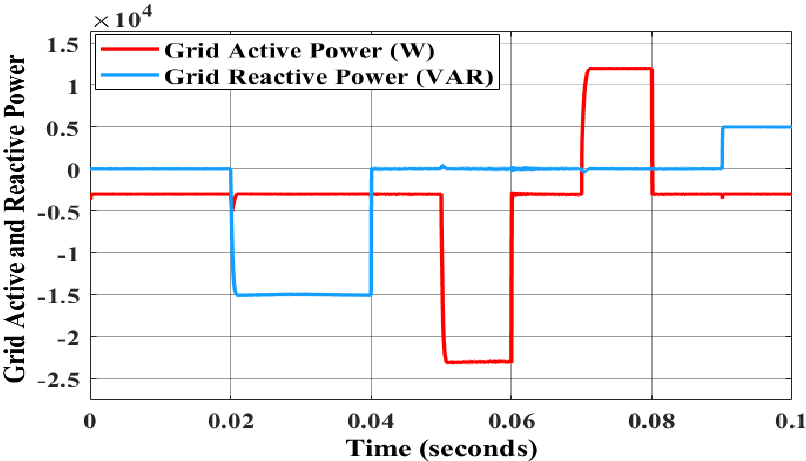
Figure 21. Active and reactive net power flows to the grid under the second case study without DG outage or with a third DG outage.